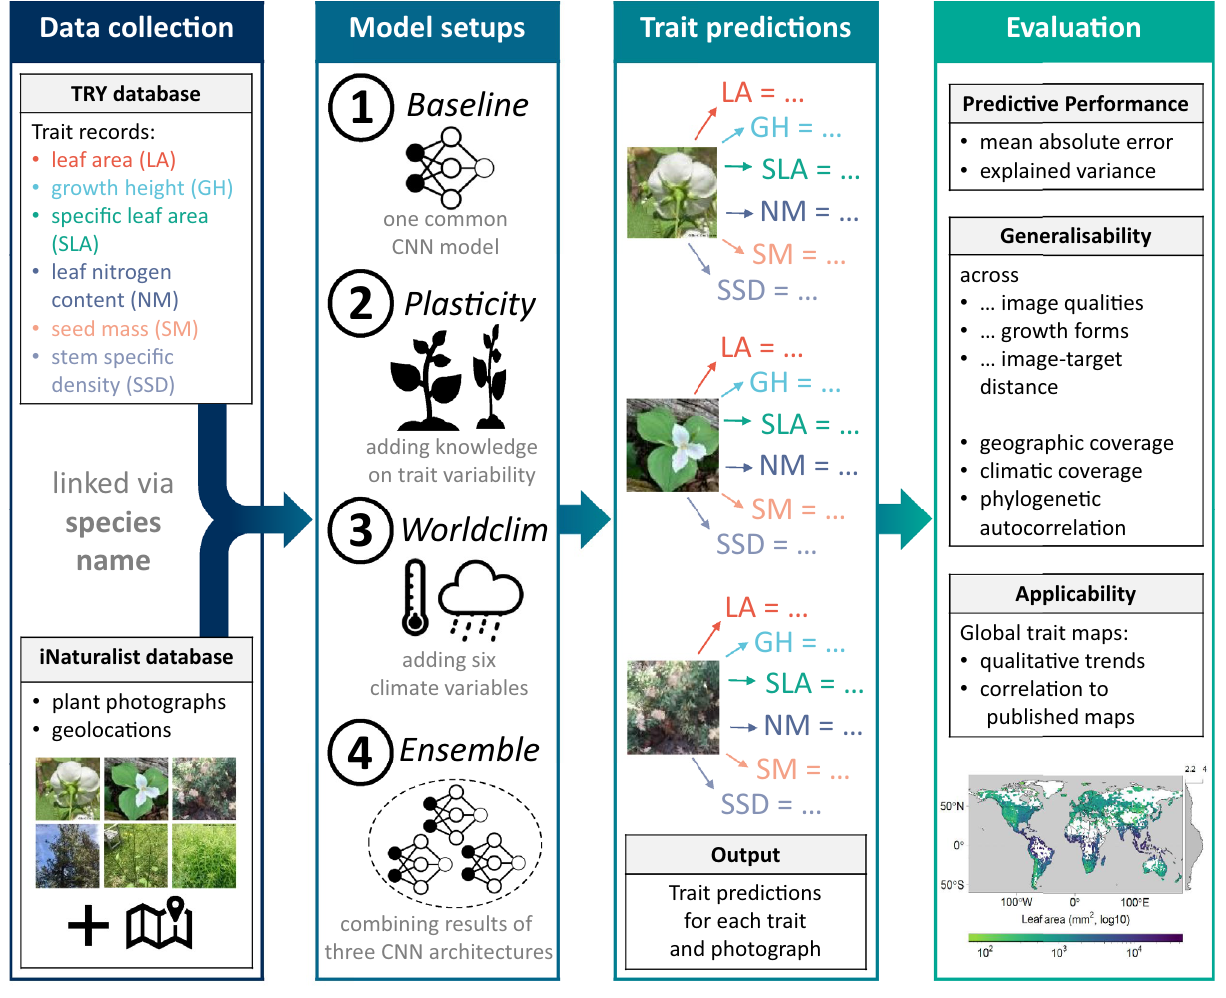
Figure 1. Conceptual diagram of the analyses, from data collection to evaluation. Data collection included linking plant functional trait records from the TRY database and plant photographs from the iNaturalist database via species names. The Convolutional Neural Networks were trained in four setups, which enabled trait predictions. The evaluation included analyses of predictive performance, generalisability and applicability. CNN, Convolutional Neural